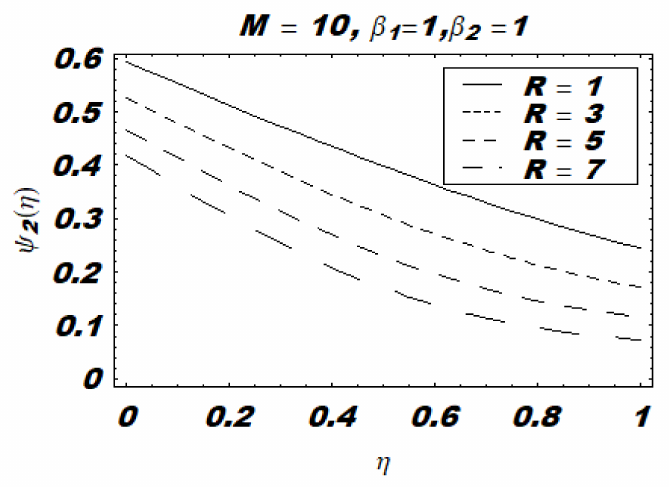
for the long slider. 3